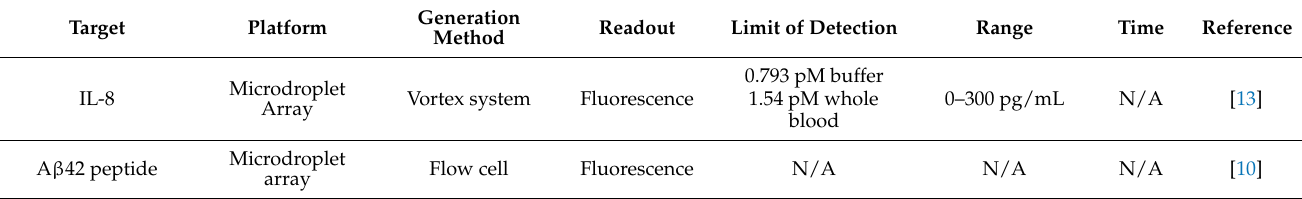
Table 1. Summary of existing dELISA